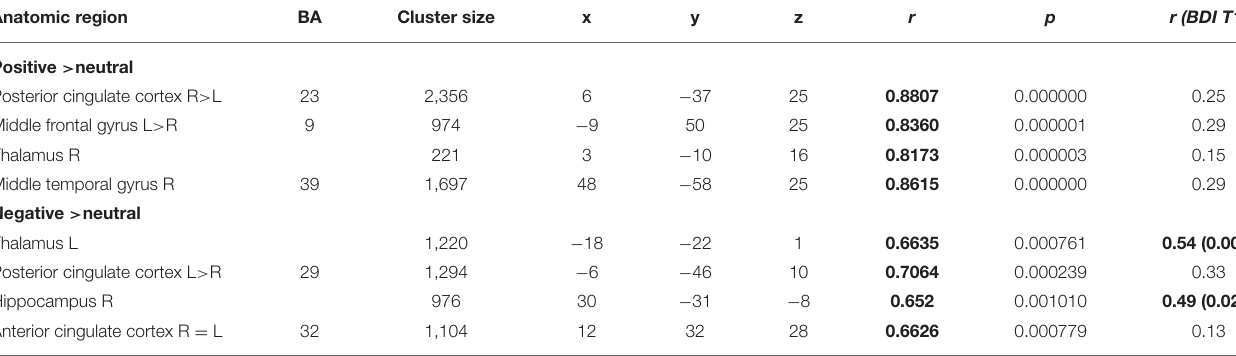
TABLE 2 | Correlation analysis: activity in regions of interest significantly associated with change in BDI. Anatomic